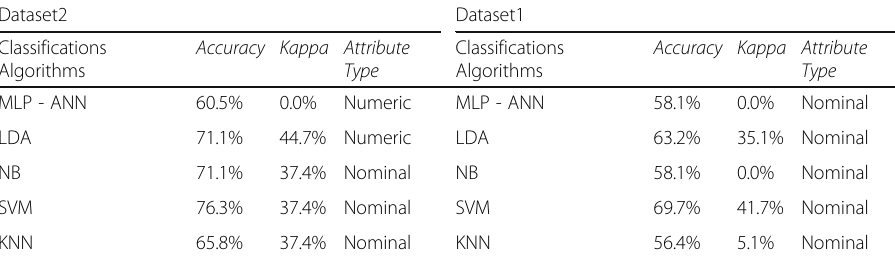
Table 9 Dataset 1 and 2 with latest chosen attributes type, that records the highest accuracy and kappa